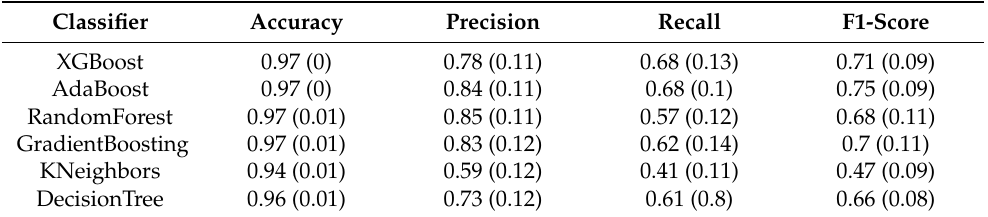
Table 4. Models’ performance for Linear Interpolation with only small packets (standard deviation in brackets).